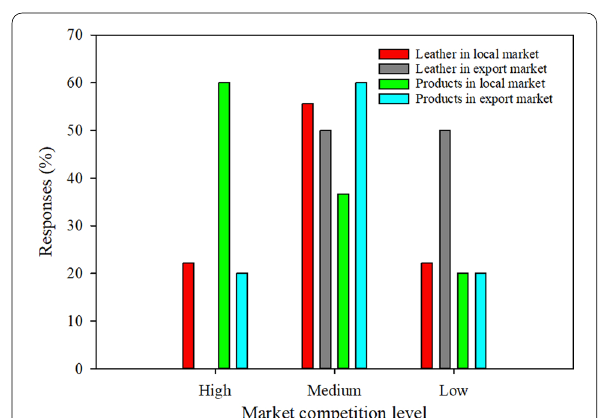
Fig. 8 Level of competition in the local and export market for leather and leather